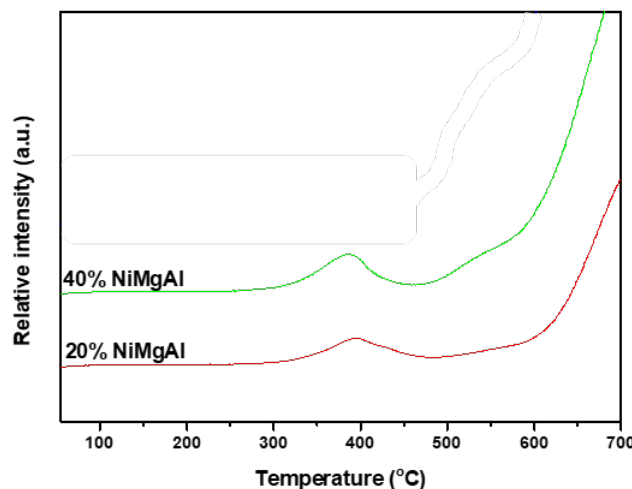
Figure 12. Hydrogen temperature-programmed desorption profiles of 20 and 40 wt% Ni-Mg-Al catalysts (supported by KIER).